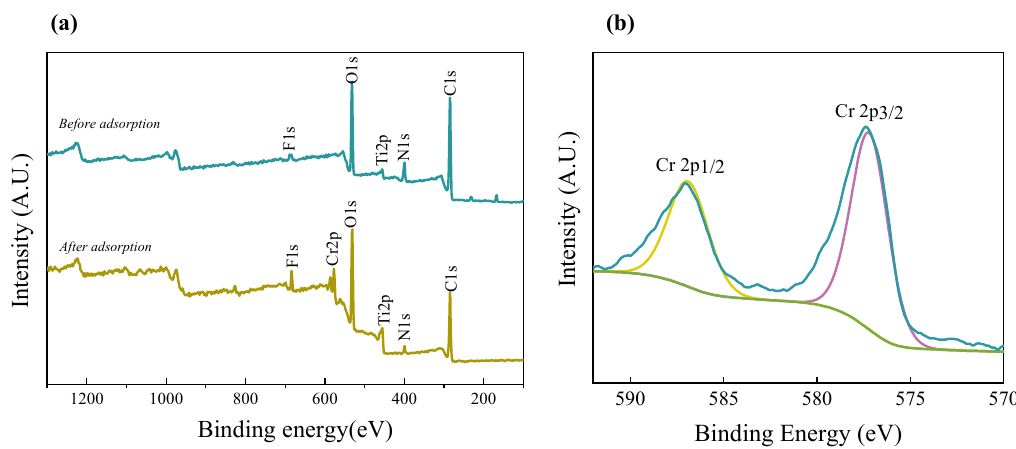
Figure 10. XPS spectra from Mxene–CS before and after adsorption: ( a ) Full–range XPS spectra, ( b ) Cr 2p. Table 4. Comparasion for removal of Cr(VI) through different materials from an aqeous